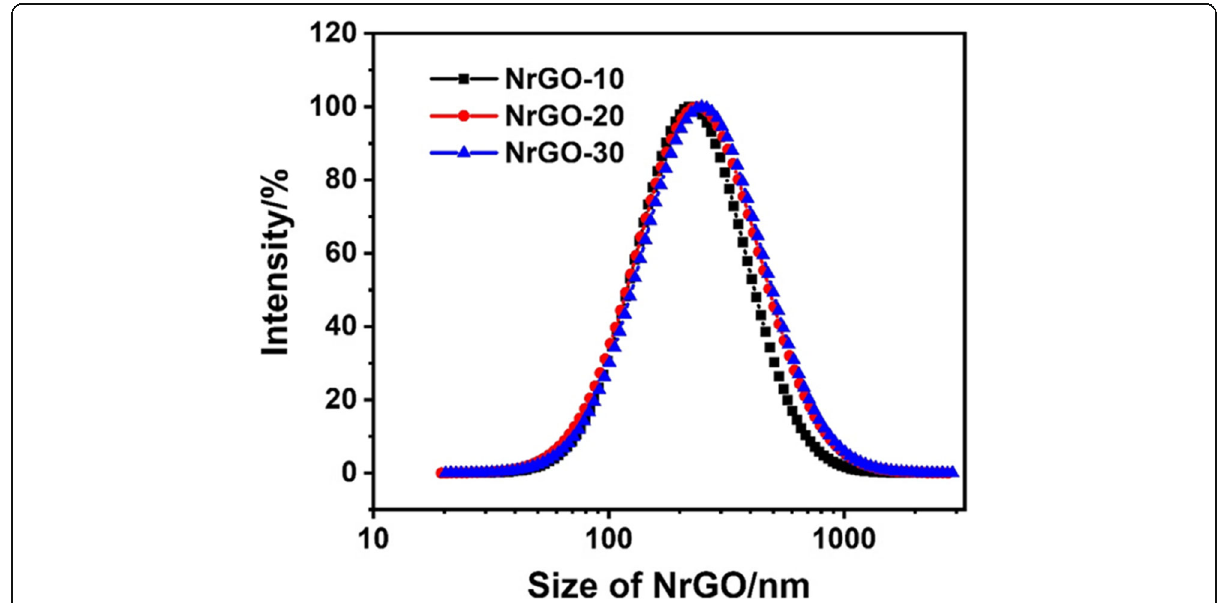
Fig. 6 Nanosize measurement of NrGO